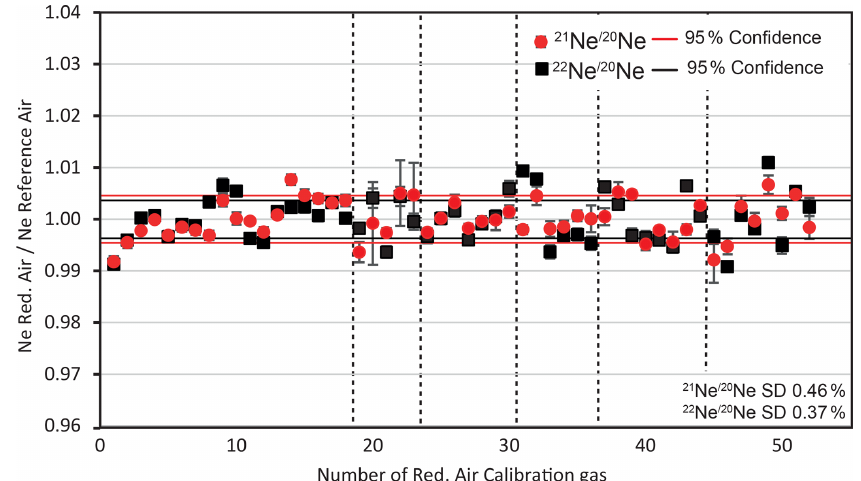
Figure 4. Reproducibility of standard gas RedAir measurements for sample runs at CGN noble gas lab, during the period between March 2020 and December 2020. Isotopic ratios are normalised to air for each run (mean of isotope ratios obtained in the run). The larger errors of the 21 Ne / 20 Ne ratios of the second run may be due to the fact that prior to that run a longer development period of other noble gas species, and other sample materials, was conducted. During developmental work on a noble gas line, particularly when other gas species are analysed, the residual gas composition in the extraction line and in the mass spectrometer may change. The latter may affect the response and stability of multipliers ( 21 Ne is the only isotope we measure on the multipliers; thus it is the 21 Ne / 20 Ne that shows the higher variability). Stippled black lines delineate individual runs. Error bars on individual data points are ± 1 σ . Symbol size is commonly larger than the corresponding error bars, which may therefore be hidden.